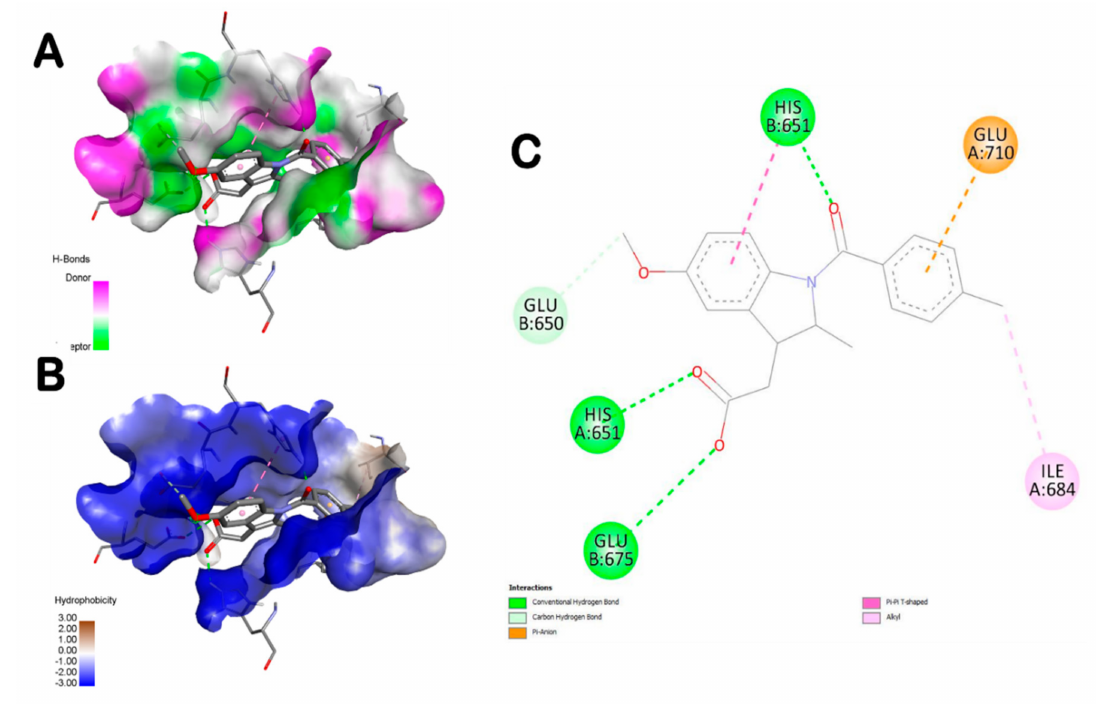
Figure 5. Representation of the 3D structure of indomethacin bounded to the pocket region of TLR6. Micrographs of the pocket region with hydrogen bond ( A ) and hydrophobicity illustrations ( B ) and the corresponding 2D diagram of interactions ( C